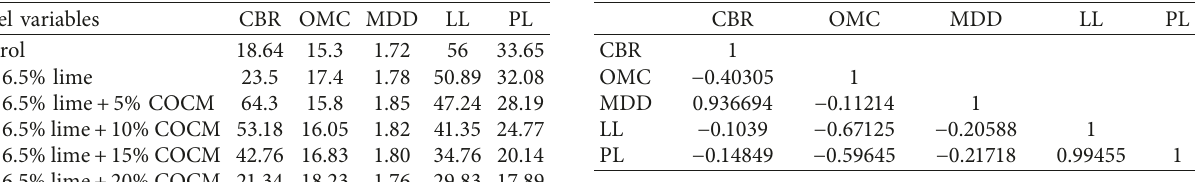
Figure 10 presents the multiple linear regression (MLR) residual plot that ensures that the regression model as- sumptions are satisfied; the statistical plots show the normal